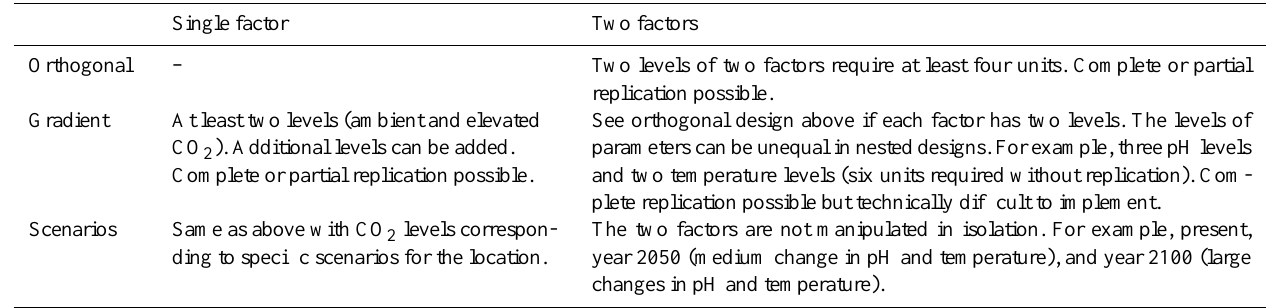
Table 2. Possible experimental designs of FOCE experiments. Single factor Two factors Orthogonal Two levels of two factors require at least four units. Complete or partial Gradient